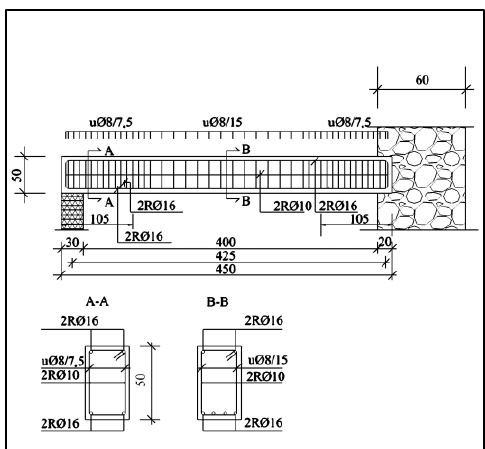
Figure 36. RC cornices with stone Figure 36. Plan of floor attic reinforcing.